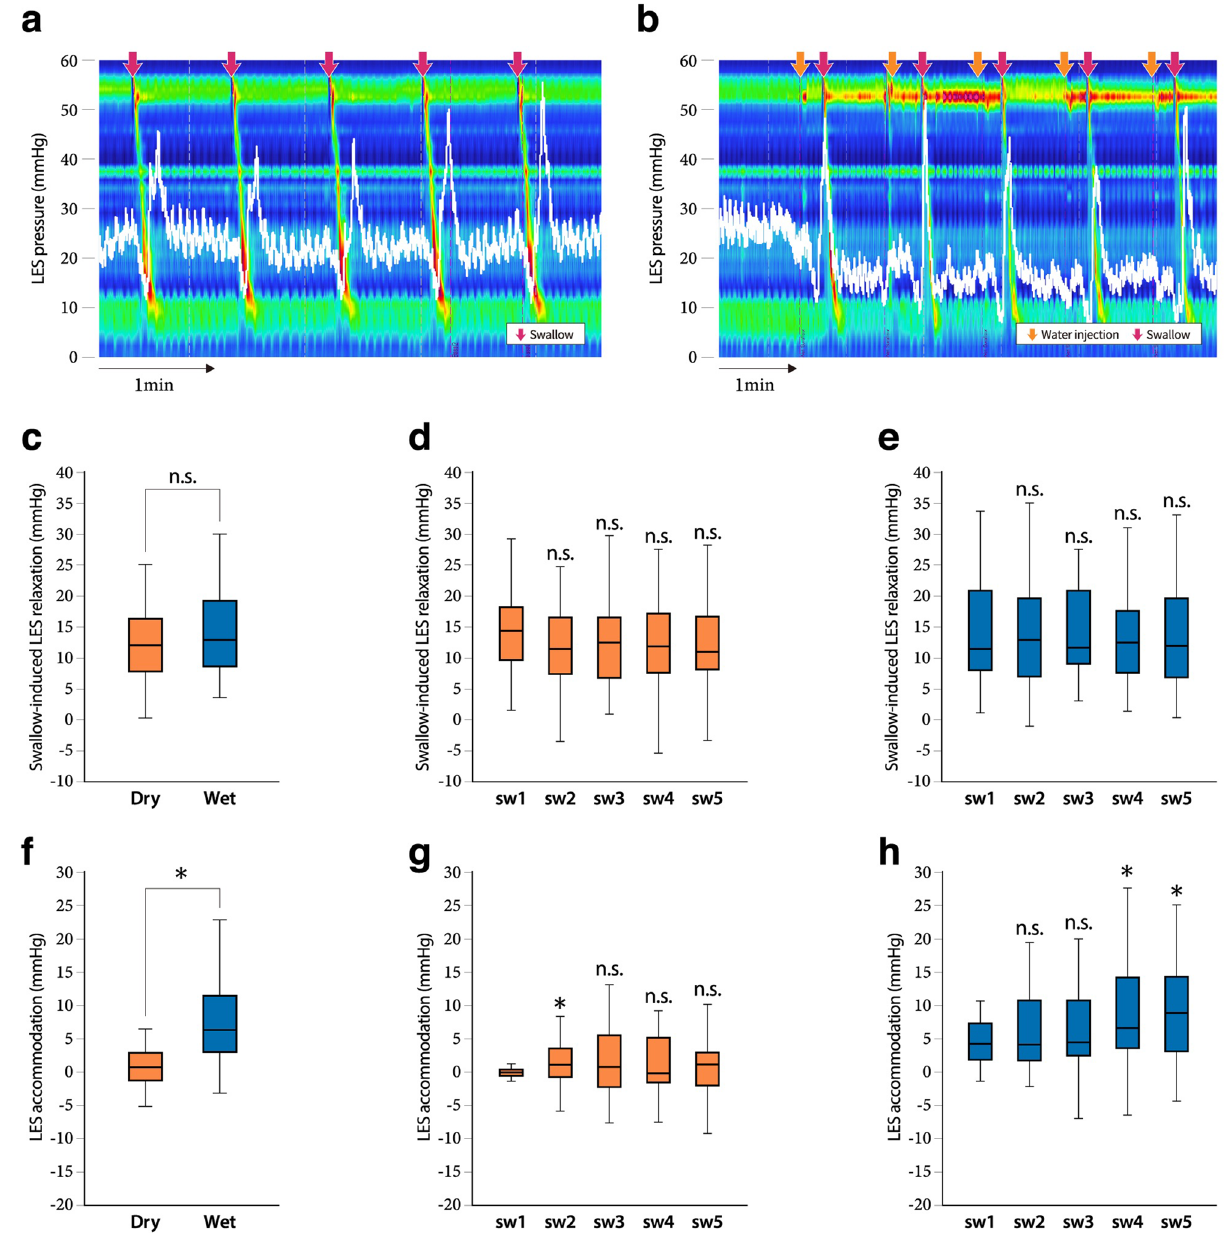
Figure 1. A comparison of the HRM findings between dry and wet swallows for swallow-induced LES relaxation and LES accommodation. a, b, A series of representative recordings of dry ( a ) and wet ( b ) swallows. Red arrows indicate the swallowing action while orange arrows indicate the timing of water injection into the oral cavity. The patients were asked to hold 5 mL water in the pharynx for 5 s before swallowing. ( c – e ), Cumulative data of swallow-induced LES relaxation in a total of five dry and wet swallows ( c ) and in each dry ( d ) and wet ( e ) swallow from the 1st to 5th swallows. ( f – h ), Cumulative data on LES accommodation in a total of five dry and wet swallows ( f ) and in each dry ( g ) and wet ( h ) swallow from the 1st to 5th swallows. Data are shown as the median (interquartile range). A paired t-test was conducted ( c and f ). *A statistically significant difference between the two groups. n.s., no significant difference between the two groups. A repeated measure analysis of variance followed by Dunnett’s test was conducted ( d , e , g , h ), with the value of the 1st swallow (sw1) set as the control. *A statistically significant difference vs. sw1 ( p < 0.05). n.s., no significant difference vs.